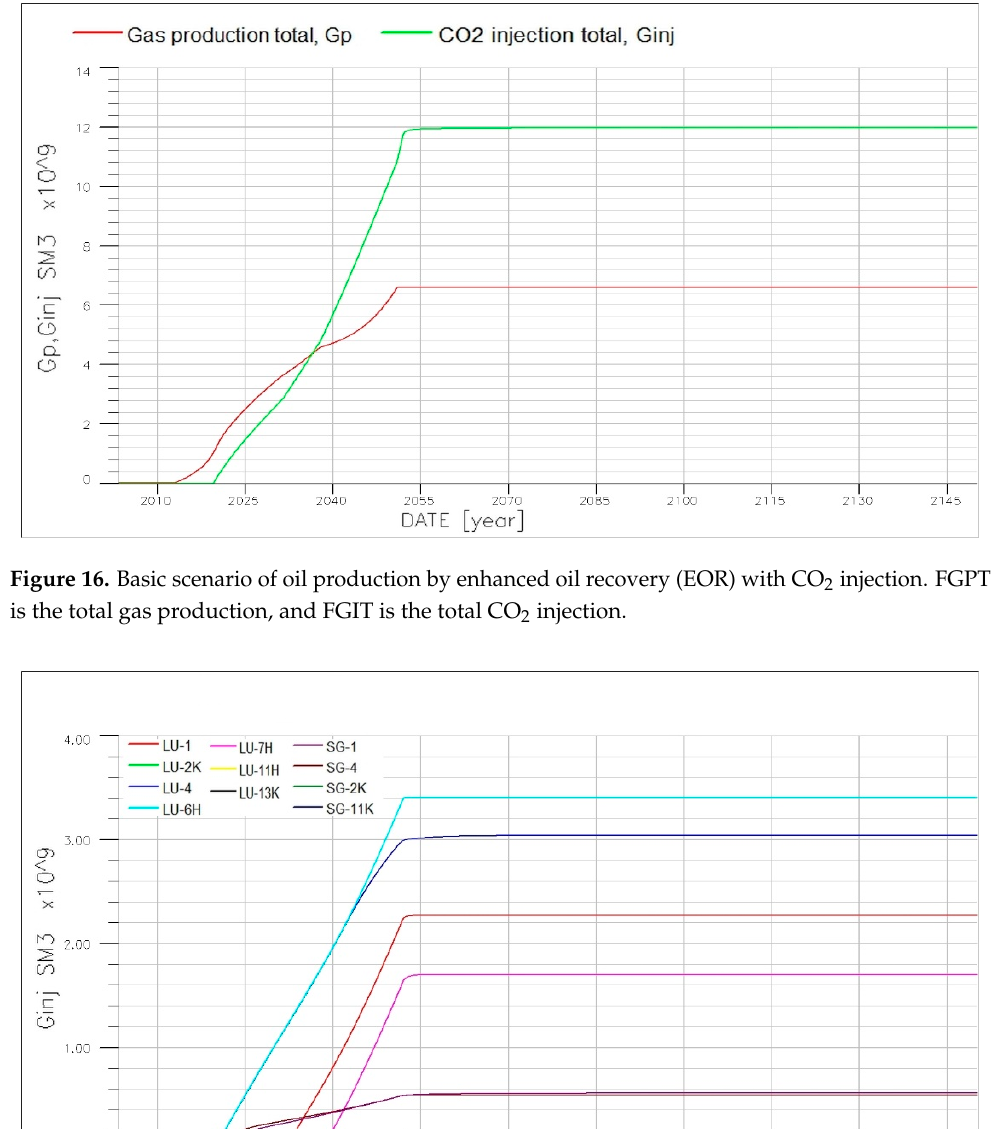
Figure 15. Basic scenario of oil production by enhanced oil recovery (EOR) with CO 2 injection. Np is the total oil production of individual wells.